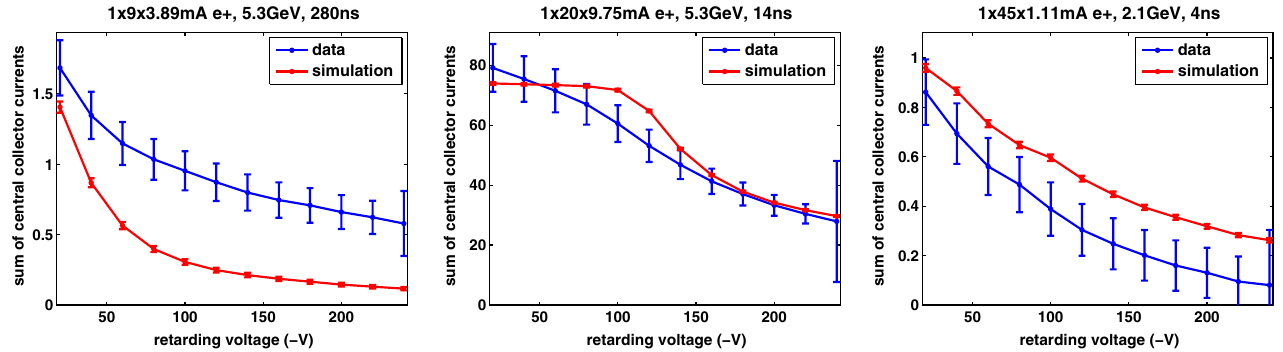
FIG. 14. Comparison of L3 NEG RFA data and simulation, using best fit parameters (Table VII). The RFA is “ APS ” style (Table II). The plots show the signal in the collector vs retarding